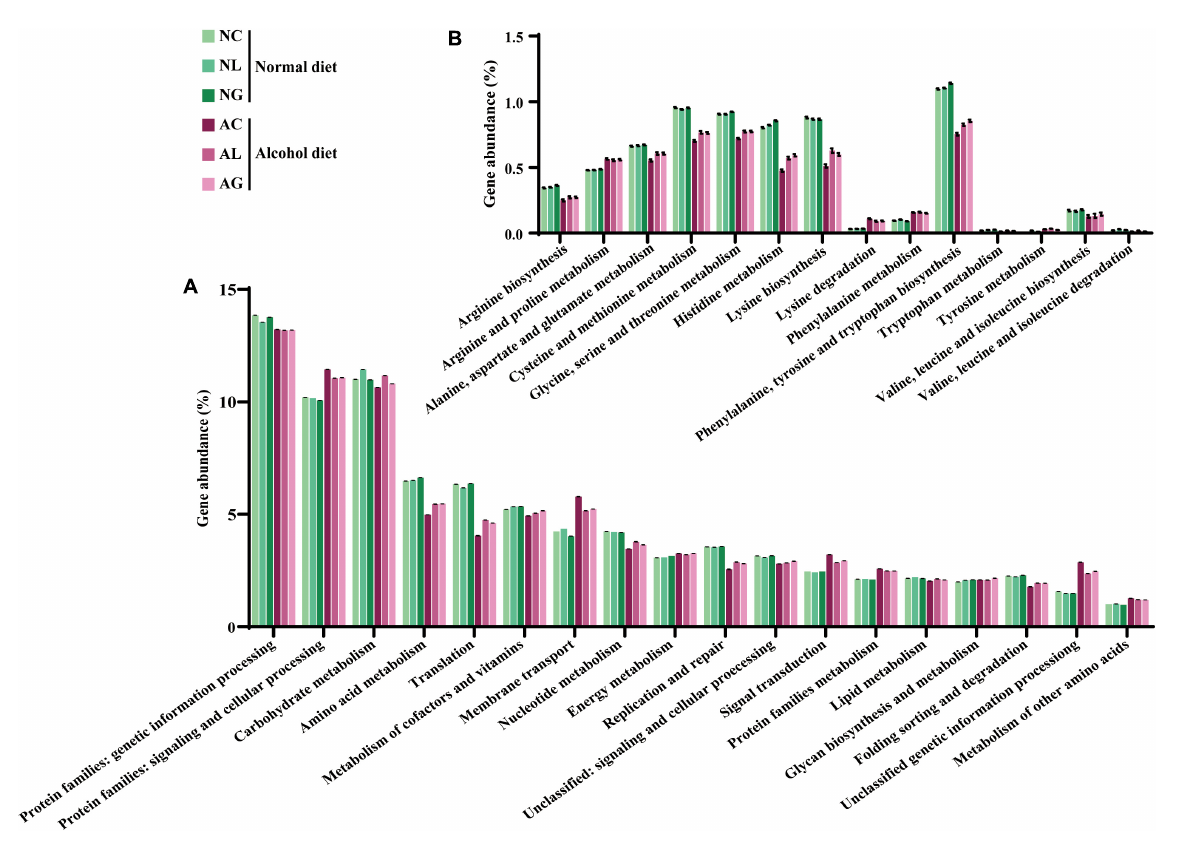
FIGURE7 Predicted gene abundance profiles of representative KEGG BRITE functional categories. Data were obtained at (A) Secondary and (B) tertiary (amino acid metabolism) levels. Data are presented as the mean ± standard deviation. NC, normal diet group; NL, normal diet and Lactiplantibacillus ( Lp .) plantarum DSR J266 + Levilactobacillus ( Lv .) brevis DSR J266 group; NG, normal diet and Lacticaseibacillus ( Lb .) rhamnosus GG group; AC, alcohol diet group; AL, alcohol diet and Lp . plantarum DSR J266 + Lv . brevis DSR J301 group; AG, alcohol diet, and Lb. rhamnosus GG